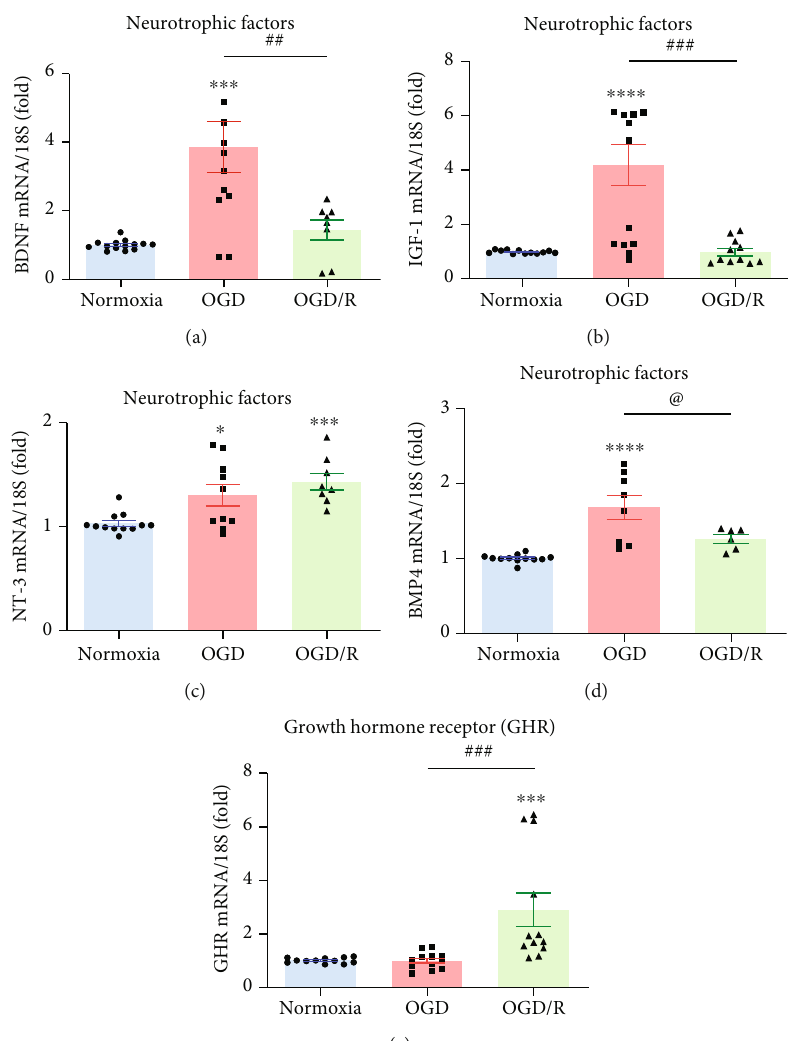
Figure 4: E ff ect of OGD and reoxygenation (OGD/R) upon BDNF, IGF-1, NT-3, BMP4, and GHR mRNA expression. Panels show the relative expression of (a) BDNF, (b) IGF-1, (c) NT-3, (d) BMP4, and (e) GHR mRNAs, determined by RT-qPCR. Relative mRNA expression values were corrected by the comparative threshold cycle (Ct) method and employing the formula 2 − ΔΔ CT . Ribosomal 18S RNA was used as housekeeping gene. Bars represent mean ± SEM . Asterisks ( ∗ ) indicate signi fi cant di ff erences in comparison to control ( ∗ p < 0 : 05 ; ∗∗∗ p < 0 : 001 ; ∗∗∗∗ p < 0 : 0001 ), and number sign (#) shows di ff erences between experimental groups (# p < 0 : 05 ; ## p < 0 : 01 ; ### p < 0 : 001 ) as assessed by one-way ANOVA and Tukey as posthoc test. An unpaired Student ’ s t -test was used to compare OGD versus OGD/R (d), and the at sign (@) indicates a signi fi cant di ff erence (@ p < 0 : 05